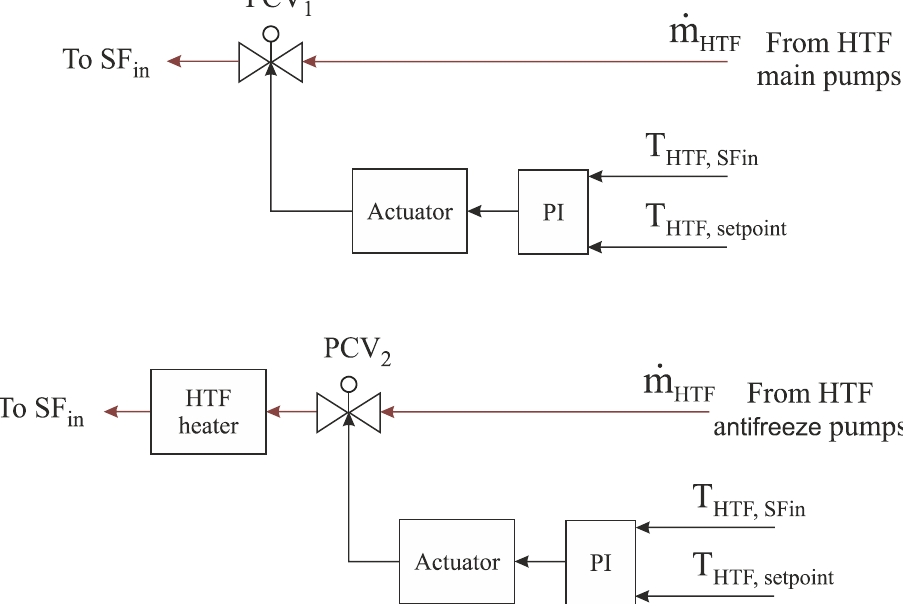
Figure 9. HTF protection control valve (simplified).